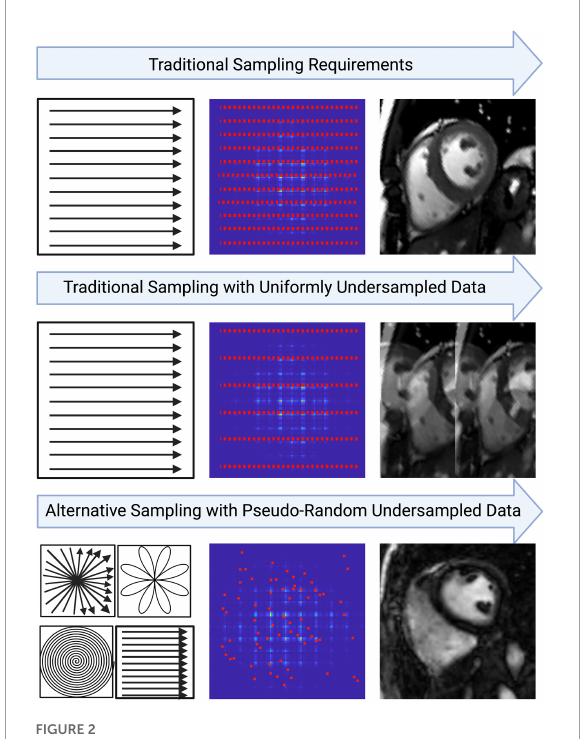
FIGURE2 An example of how image quality may be affected from the way data is sampled in k-space. Traditional cartesian k-space sampling with fully sampled data results in high image quality. However, traditional k-space sampling with uniformly undersampled data results in coherent fold-over artifacts. Variable density pseudo-random undersampling allows artifacts to be incoherent in image space, approaching noise-like artifacts in some cases. This may allow the resulting image to retain diagnostic integrity despite heavy under-sampling. Oftentimes, variable density pseudo-random undersampling is achieved with alternative trajectories such as rosette, radial or spiral. The key benefits of these trajectories include the center of k-space being over-sampled which allows features like motion to be extracted and the incorporation of golden-angle sampling which strengthens the incoherence of artifacts in image